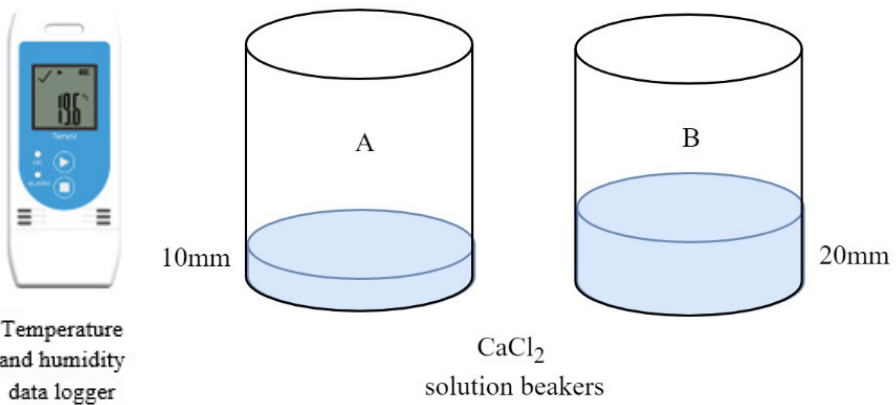
Figure 3. Experimental setup to investigate the effect of solution depth on absorption, (A) 10 mm, and (B) 20 mm CaCl 2 solution